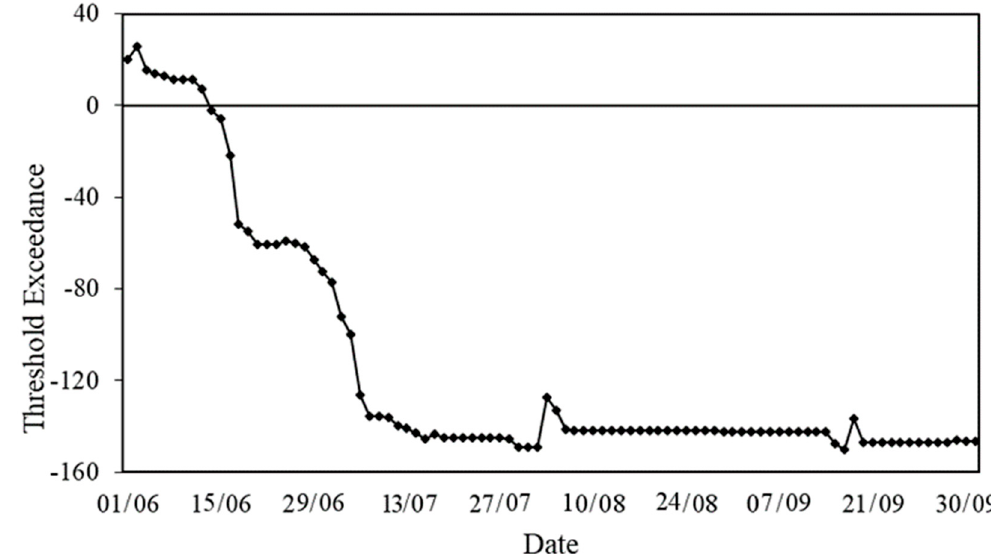
Figure 7. Validation of the threshold equation for Zone 1. The positive values on the Y axis represent exceedance and negative values denote non-exceedance of the threshold.